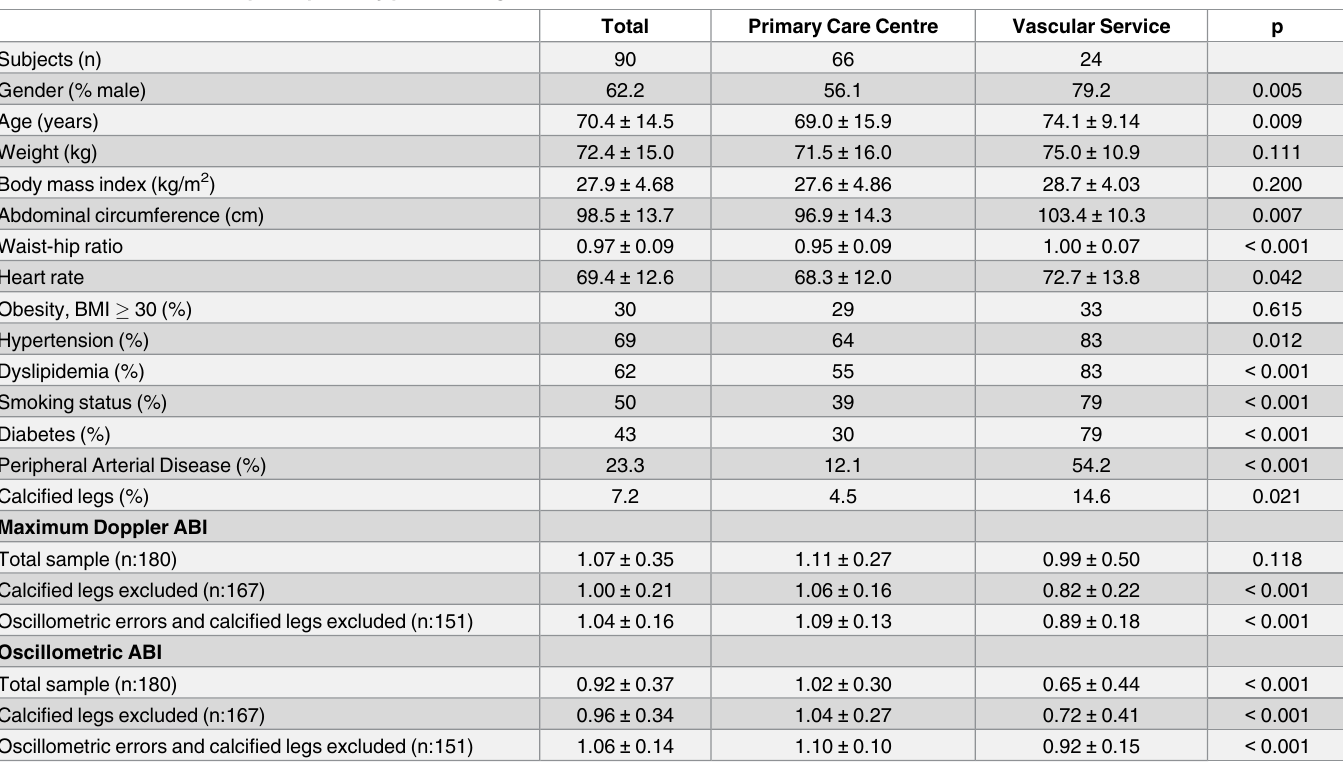
Table 1. Characteristics of participants by place of